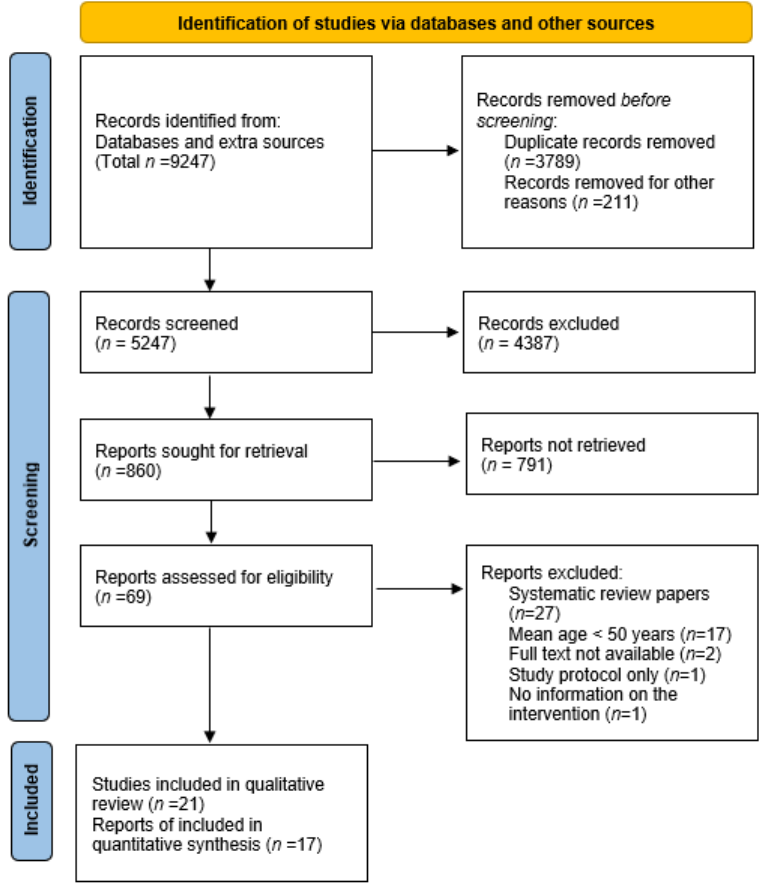
Figure 1. PRISMA Figure 1. PRISMA flowchart.